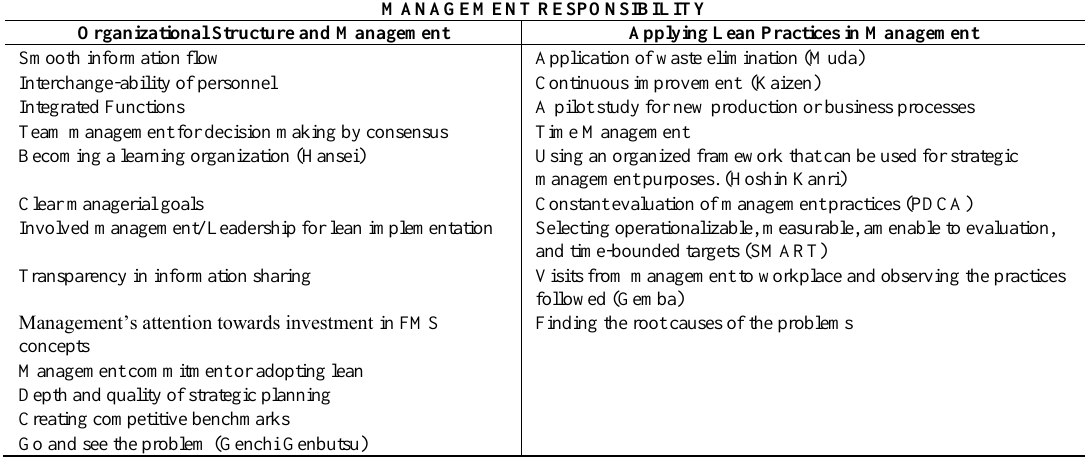
Table 9. Sub-criteria and measures for the management responsibility main criterion MANAGEMENT RESPONSIBILITY Organizational Structure and Management